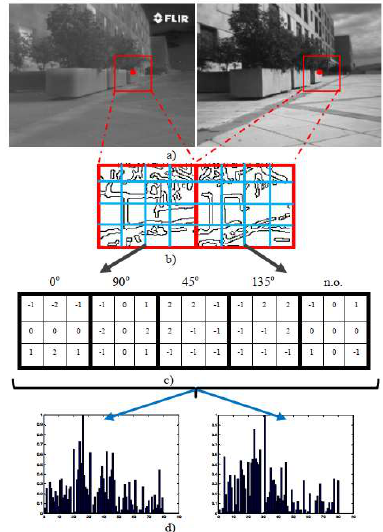
Figure 3. EHD extraction flow diagram (Mouats et al., 2013)